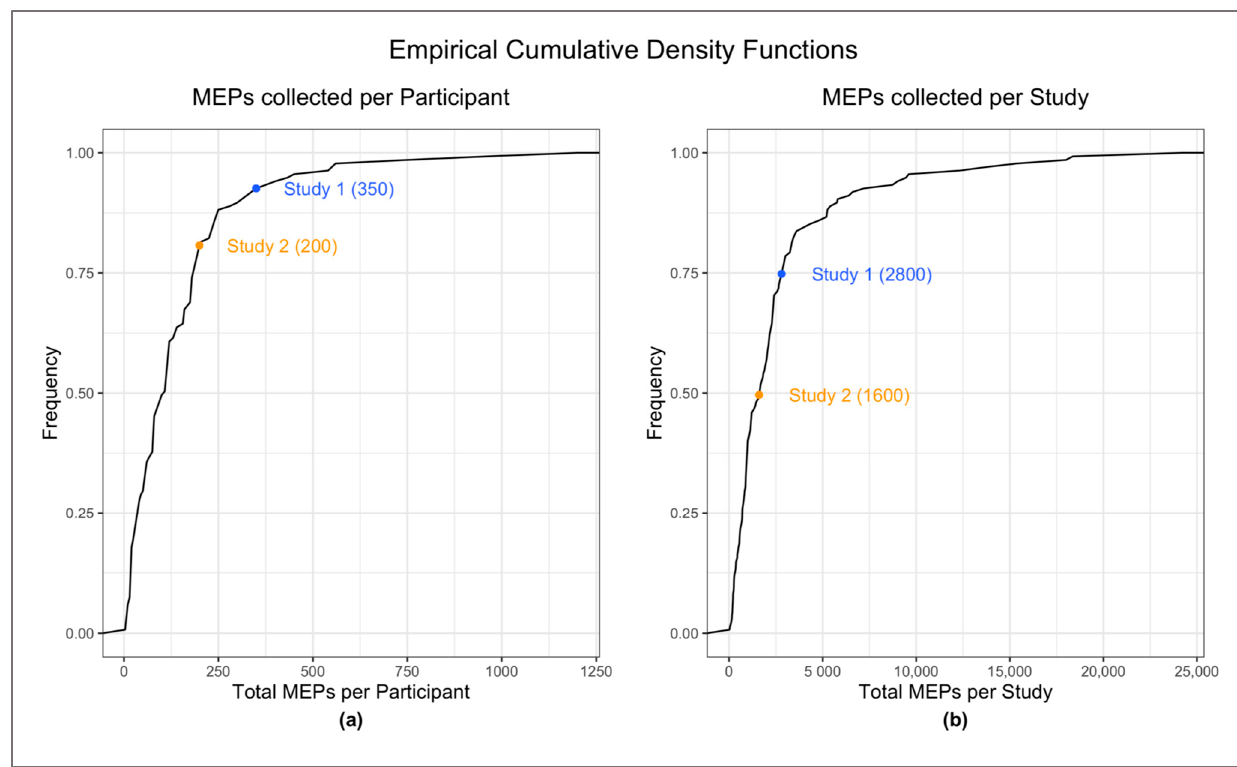
Figure 1. Empirical cumulative density functions of ( a ) total post-PAS MEPs collected per participant and ( b ) total post-PAS MEPs collected per study. Blue and yellow dots indicate where Studies 1 and 2 fall, respectively, compared to previously published studies. None of the values in the figure include MEPs collected at baseline.